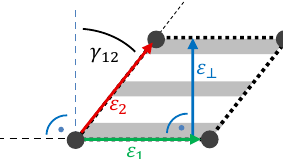
Figure 5. Distinction between transverse strain ε 2 and perpendicular strain ε ⊥